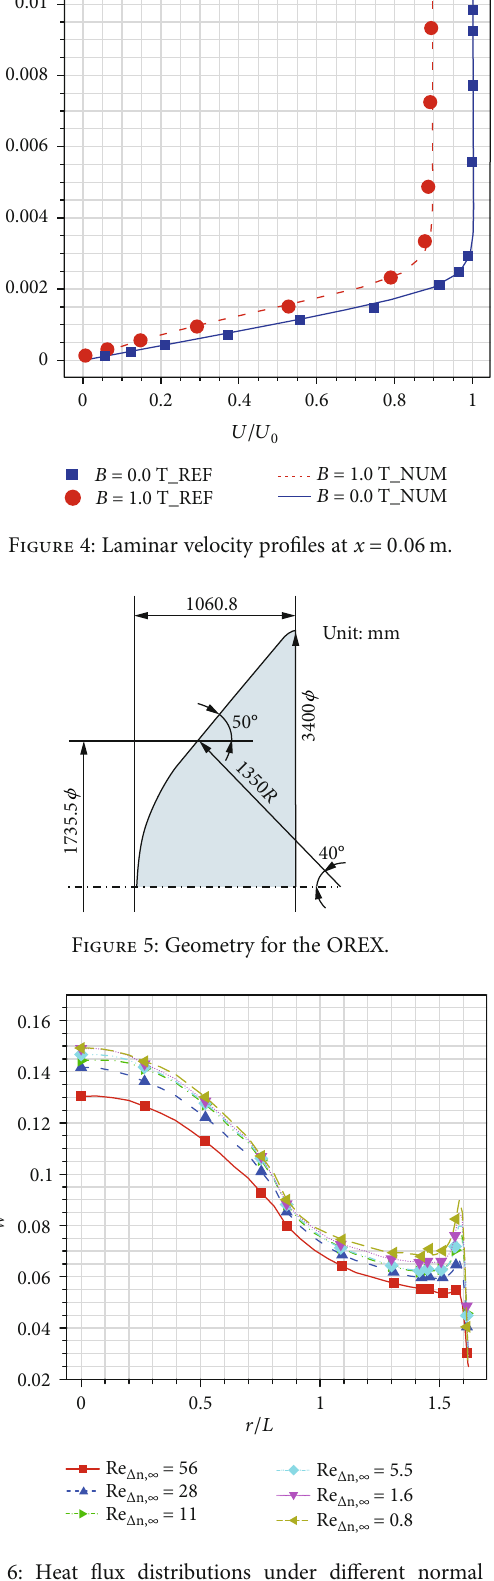
Table 3: Parameters of MHD fl ow over the 24 ° compression